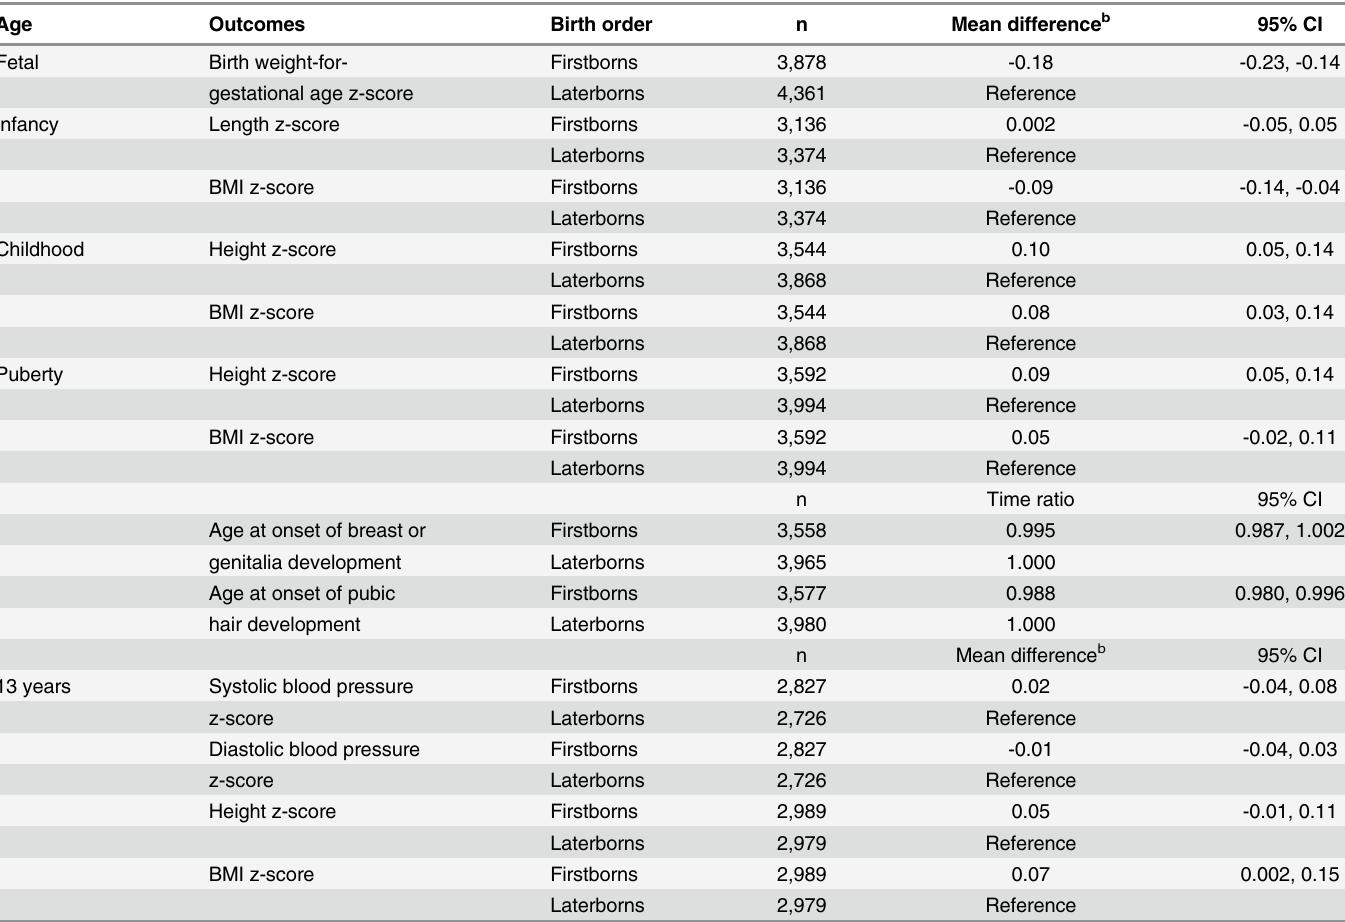
Table 2. Adjusted a association of birth order with birth weight-for-gestational age z-score for growth during fetal phase, height and body mass index (BMI) z-scores during infancy, childhood and pubertal phases, age at onset of breast or genitalia or pubic hair development (Tanner stage II) and blood pressure, height and BMI z-scores at 13 years in the Hong Kong ’ s “ Children of 1997 ” birth cohort, Hong Kong, China, 1997 –